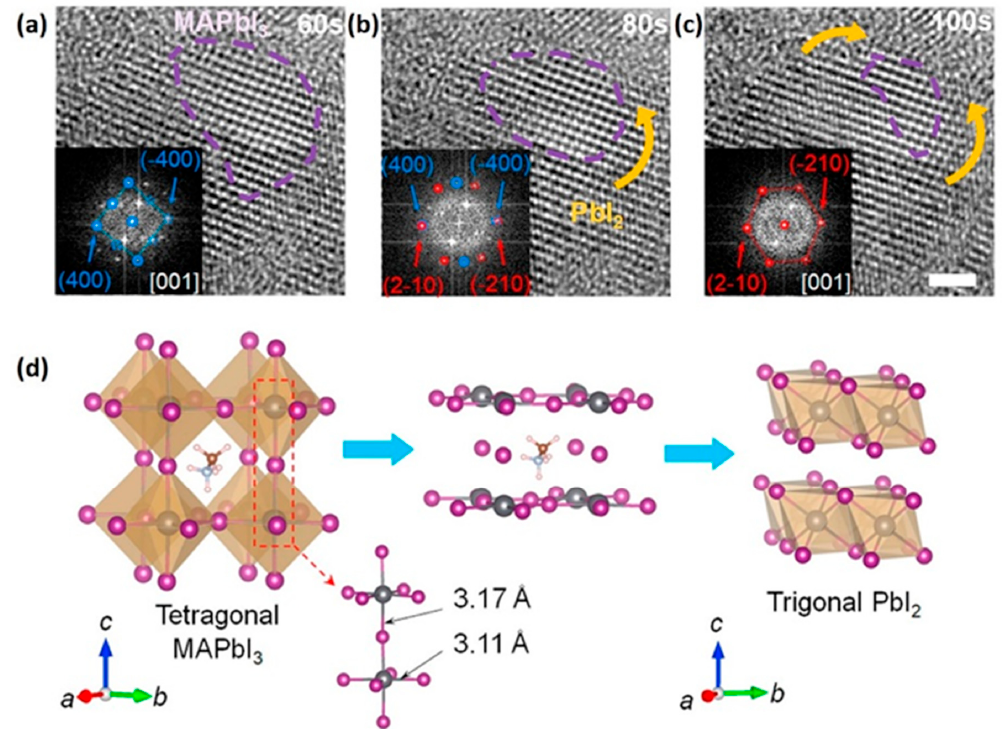
Figure 2. ( a – c ) Degradation process of MAPbI 3 grain with direct transition from tetragonal to trigonal crystalline structure. The purple dashed lines in ( a – c ) showed the shrinking of perovskite and the insets represented Fast Fourier transform (FFT) phase diagrams of the corresponding HRTEM images (Scale bar = 2 nm). ( d ) Transition from MAPbI 3 with a tetragonal configuration to PbI 2 with a trigonal configuration. Reprinted from [40], with permission from Elsevier.